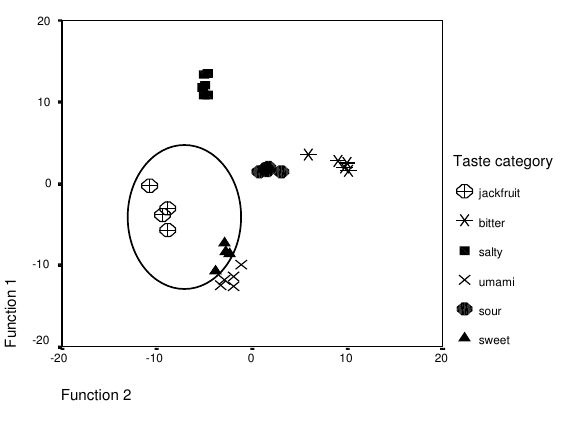
Fig.9. Identification of the “unknown” using disposable sensor strips. “Unknown” (36 th hour) was correctly classified as sweet taste which corresponds to the remarks from human panel and percentage of sugar measurement. (with reference to Table 5) Table 5 : Prediction of jackfruit taste at selected interval of time using CDA Unknown: Predicted